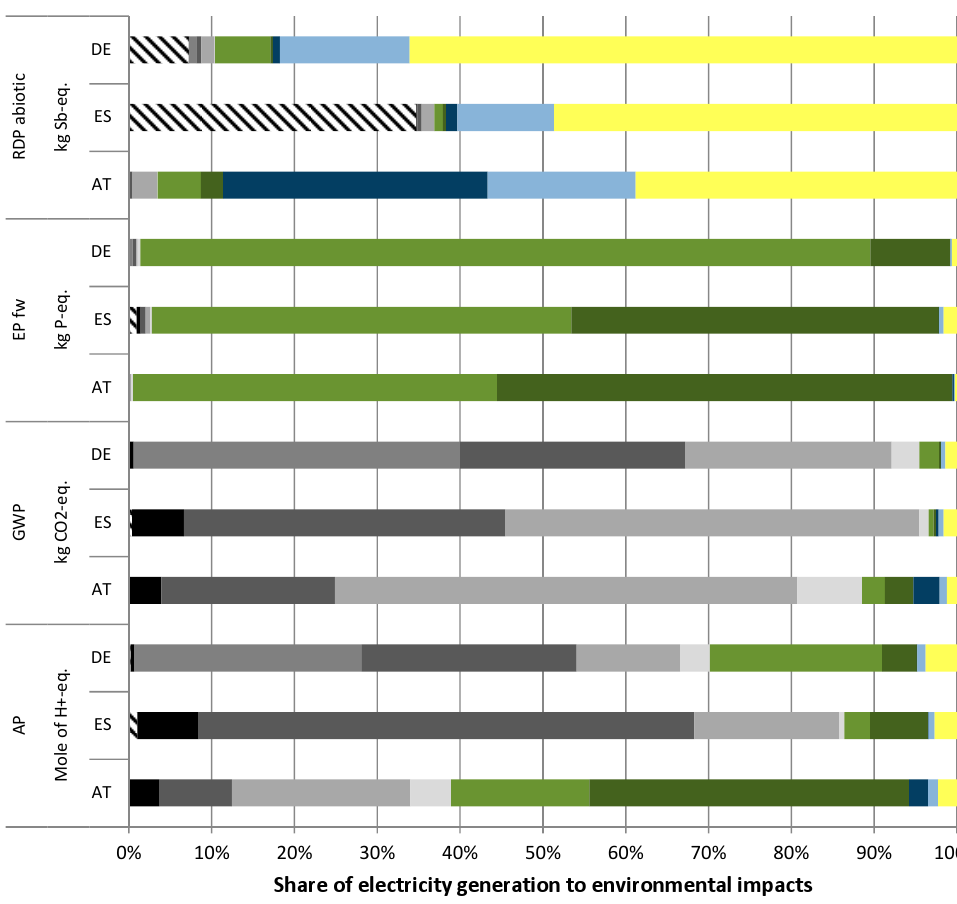
Figure 4. Contributions to environmental impacts of electricity grid mixes.